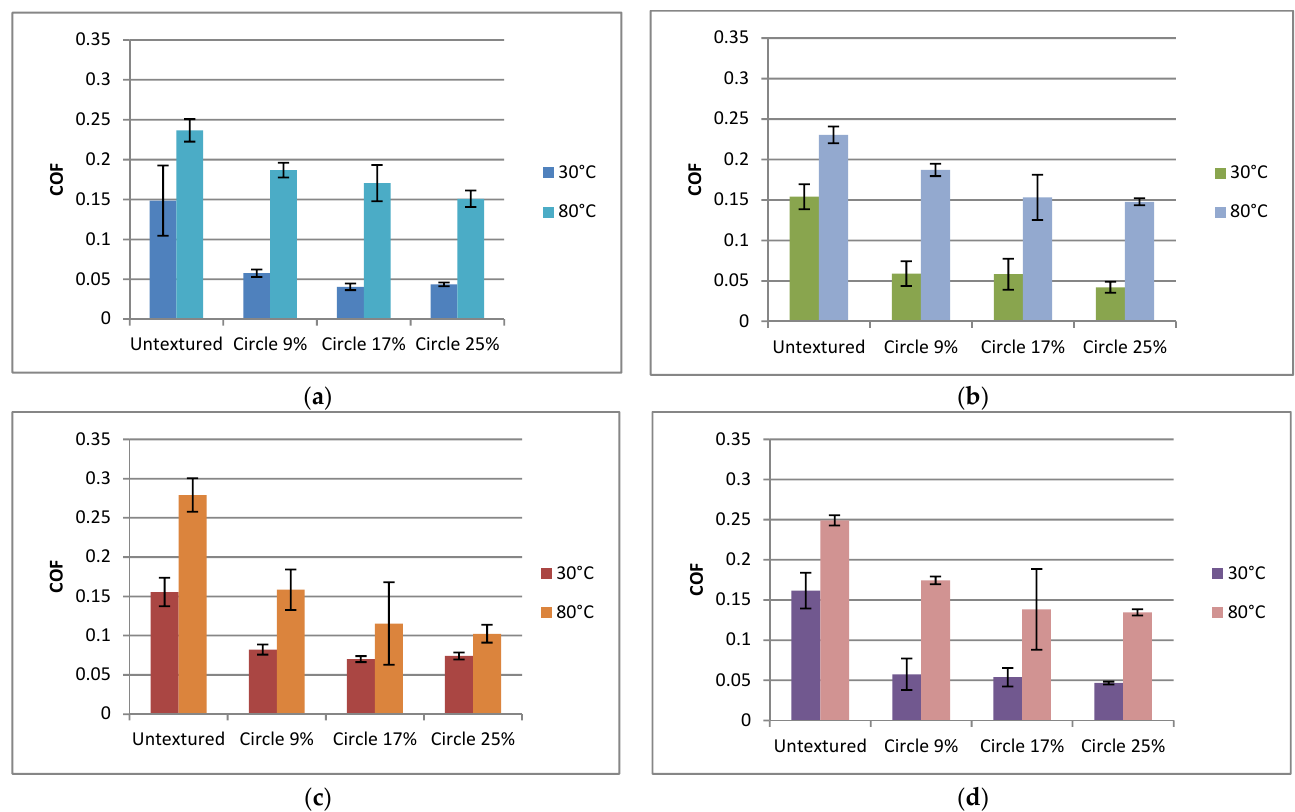
Figure 10. Average values and standard deviations of the coefficient of friction of textured and untextured sliding pairs for the following operating conditions: f = 20 Hz, p = 40 N ( a ); f = 20 Hz, p = 80 N ( b ); f= 40 Hz, p =40 N ( c ); f= 40 Hz, p = 80 N ( d ).